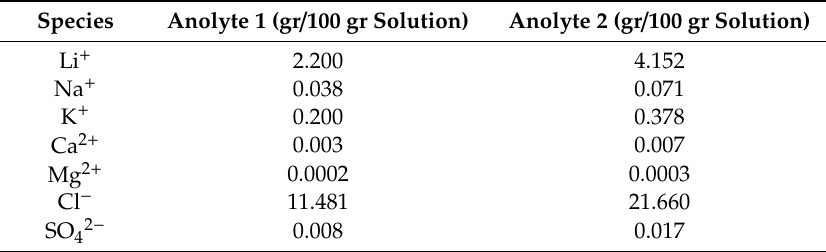
Table 1. Anolytes chemical